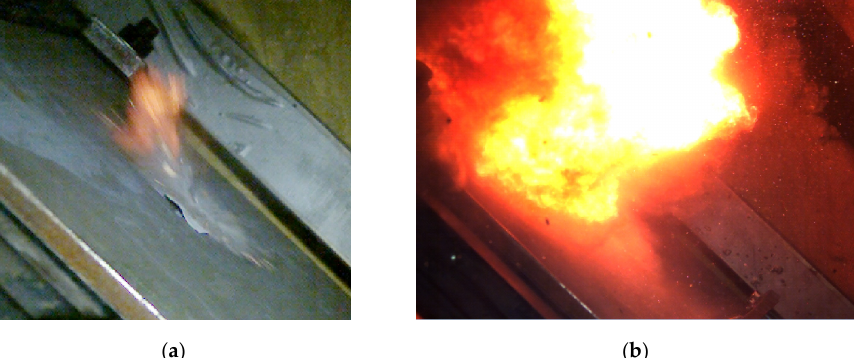
Figure 3. Recording of a fragmented projectile striking an Armox 600 armour plate (Photron Fastcam SA-Z 2100K-50,400 fps): ( a ) 7.62 × 51 mm SWISS PAP projectile; ( b ) 7.62 × 51T projectile flash caused by the rapid combustion of the streaker pyrotechnic mass.